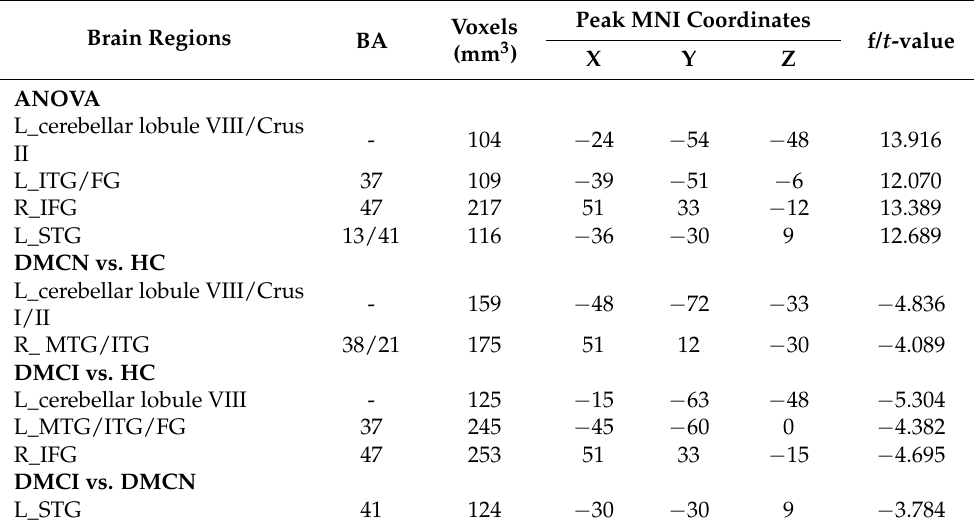
Table 2. Regions of abnormal long-range FCD among the three groups. Brain Regions